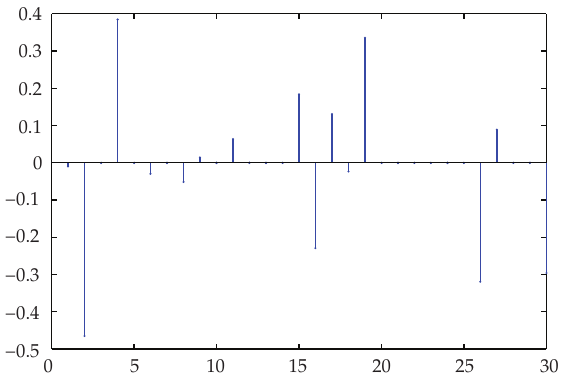
Figure 6: The correlation coe ffi cient of the aggregate flow vector and the corresponding rate.